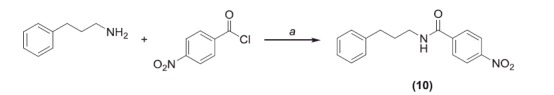
Synthesis of 10. Reagents and conditions: (a): TEA, dry CH2Cl2, 16 h, RT.